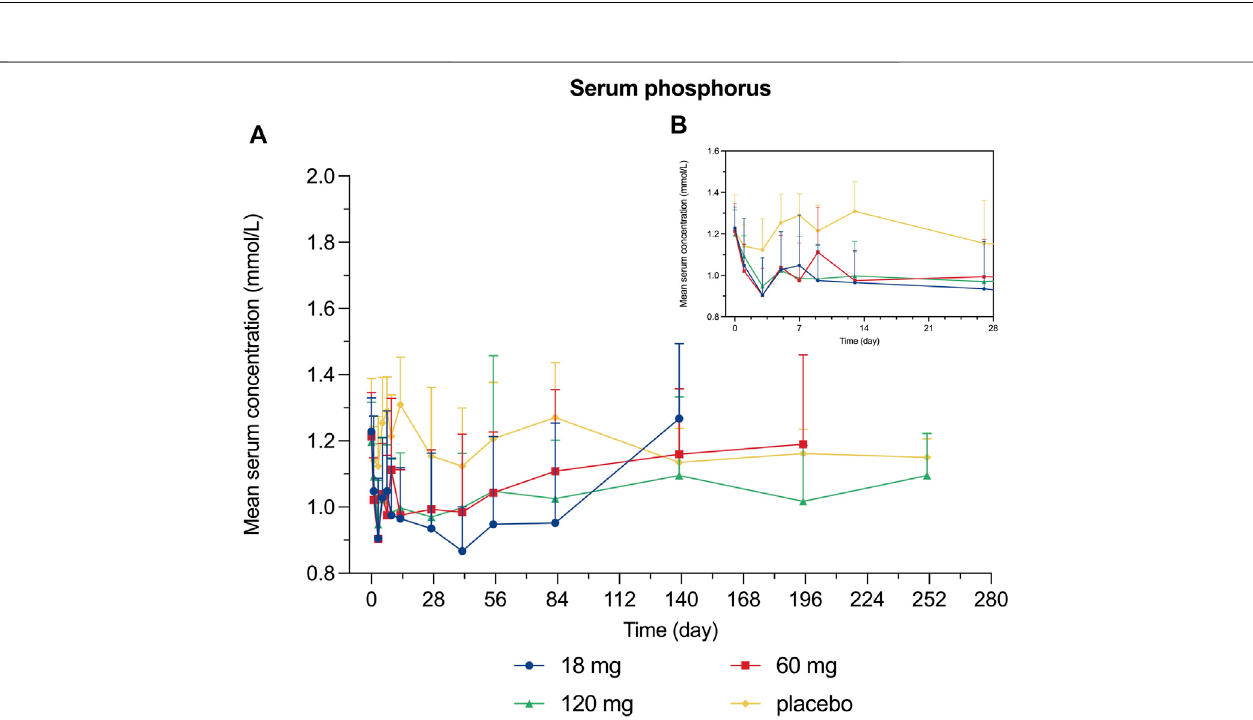
FIGURE 5 | Percent change from baseline in serum phosphorus. (A) day 0~day 252; (B) day 0~day 28.